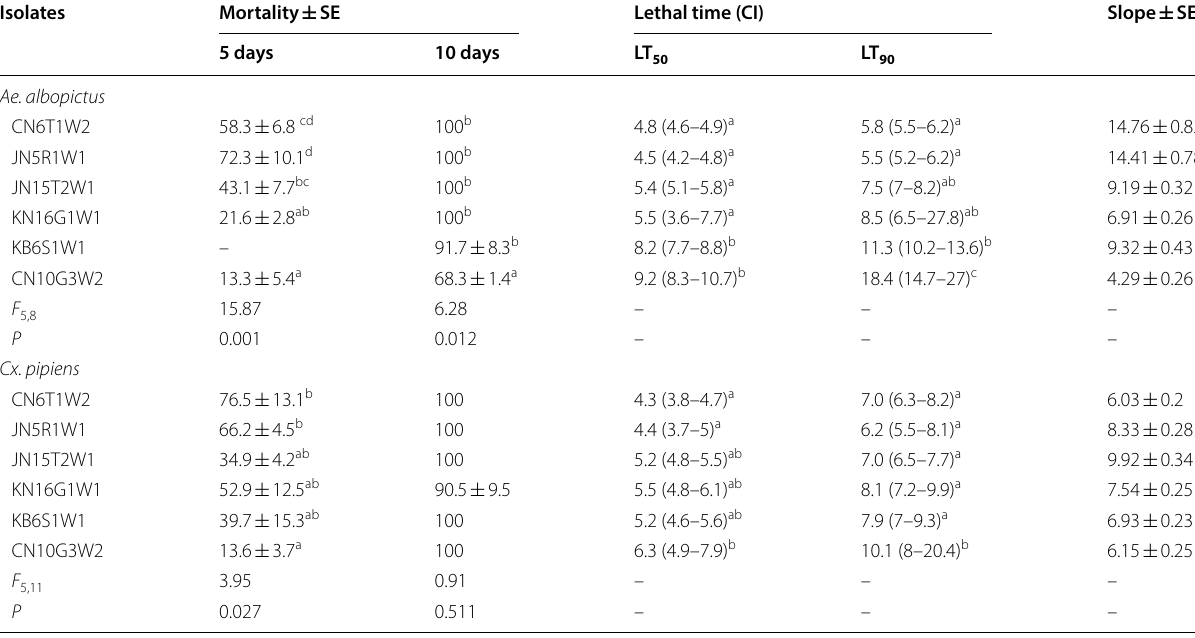
Values, based on three repetitions, in the same column for each isolate followed by different letters were significantly different based on ANOVA and SNK test (cumulated mortalities; a–d) or their CI (LT; a–c). Cumulative control mortality was